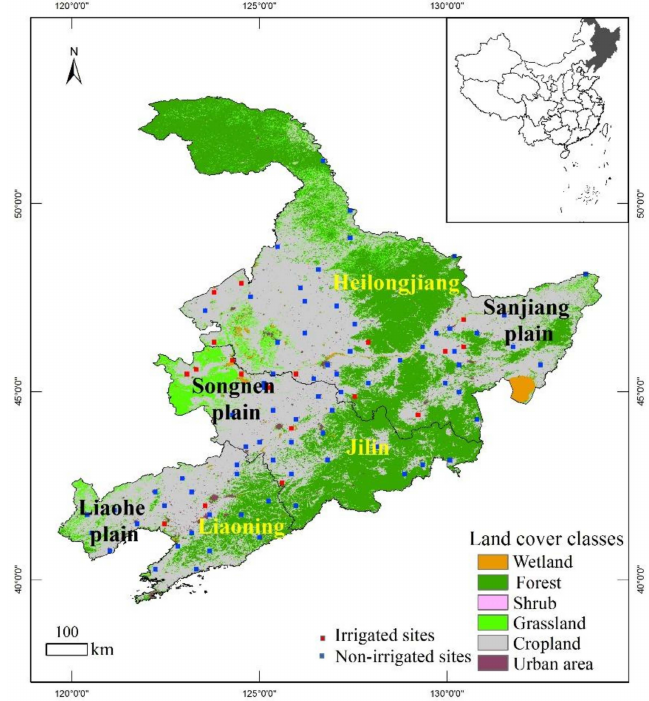
Figure 1. Land cover classes and validation samples in Northeast